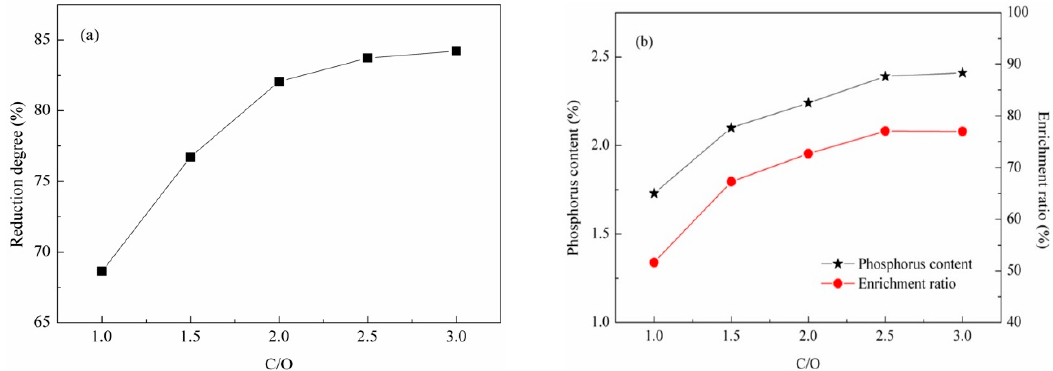
Figure 6. Effect of C/O molar ratio on the reaction behavior of phosphorus: ( a ) reduction of apatite to phosphorus; and ( b ) phosphorus enrichment in reduced iron.